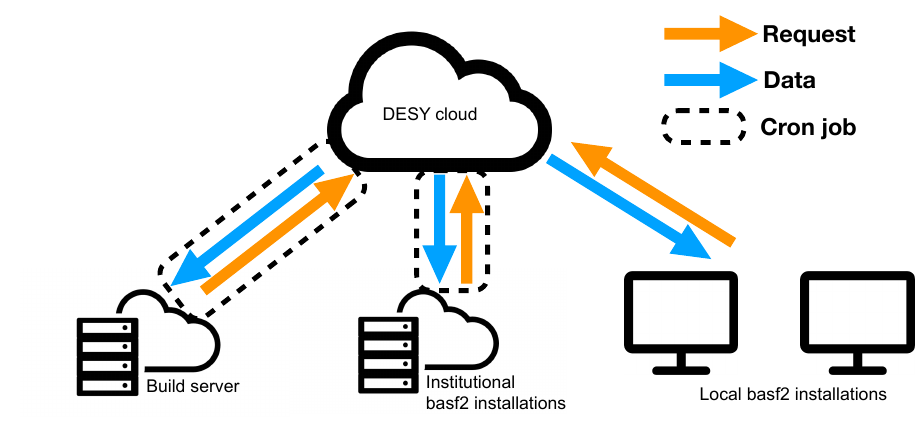
Figure 2. Scheme of the distribution of the example datasets. For the build server and the institutional installations, the request of the new datasets is done through the cron jobs, while it is done manually for the local